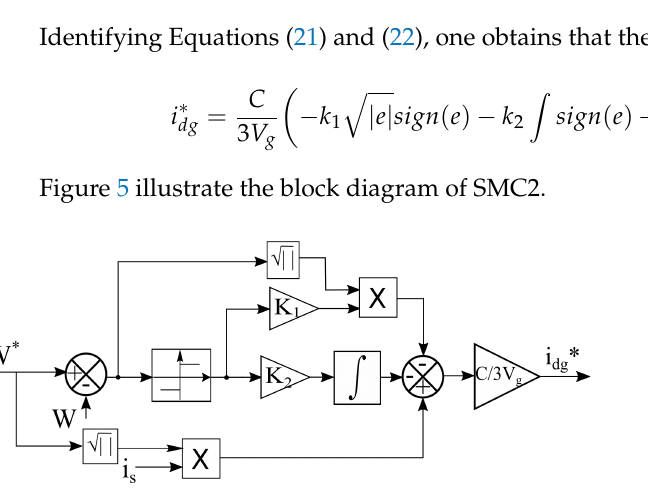
Figure 5. SMC2 controller block